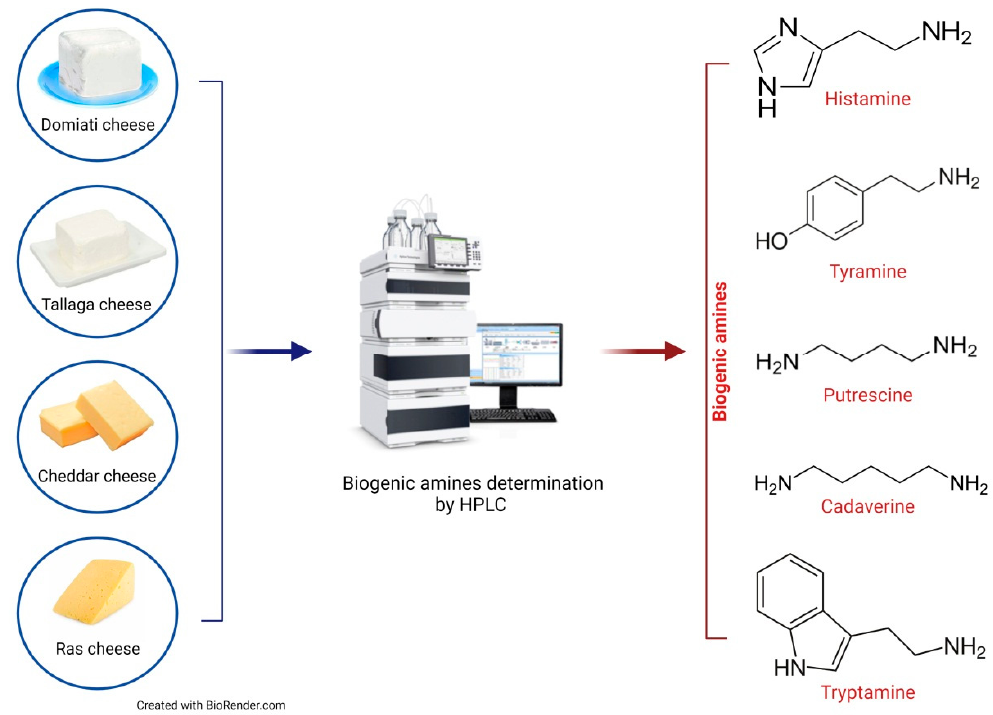
Figure 2. Diagram of different BAs detection in the investigated cheese samples by a high-performance liquid chromatography (HPLC).